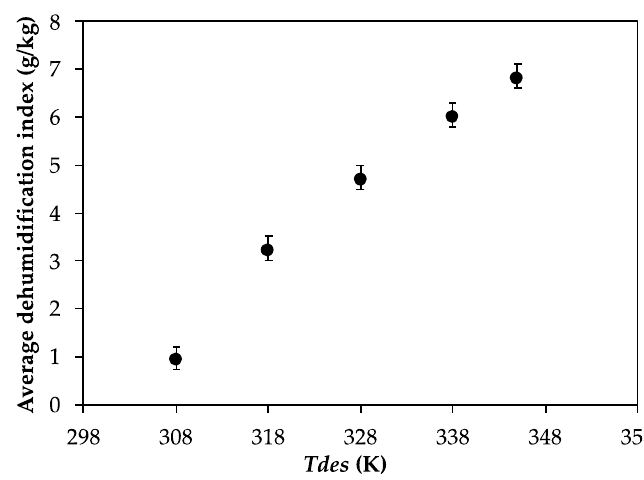
Figure 4. The influence of the desorption temperature on the dehumidification index.